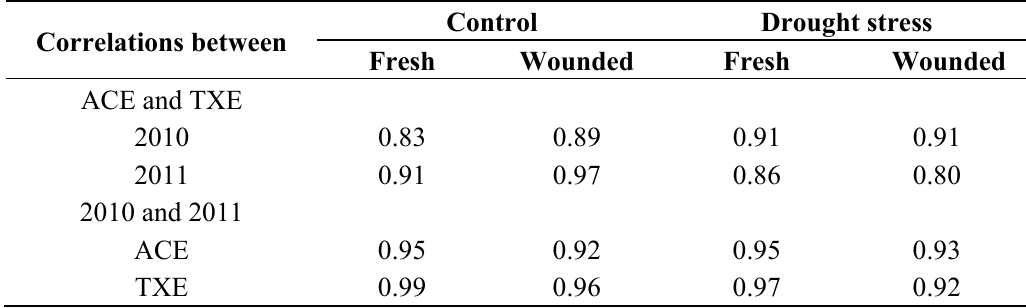
Table 7. Correlations between ACE and TXE measured in 2010 and 2011, and correlations between the two test years for ACE and TXE measured in 2010 and 2011.